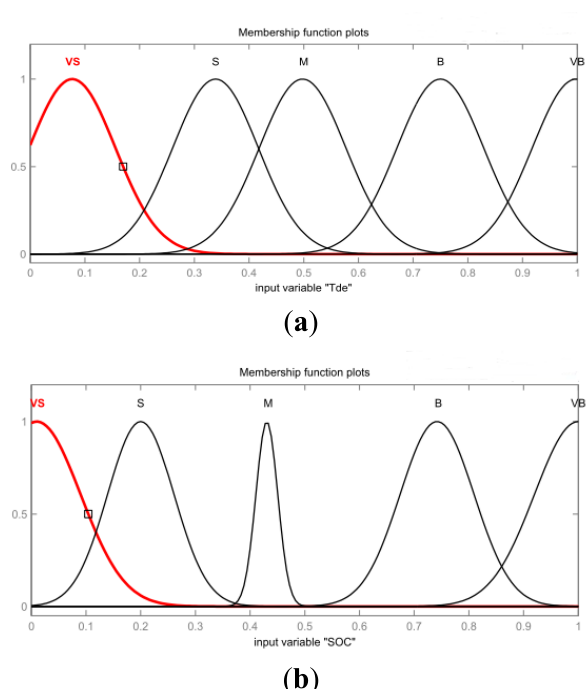
Figure 8. ( a ) Final membership functions of functions of SOC under UDDS.